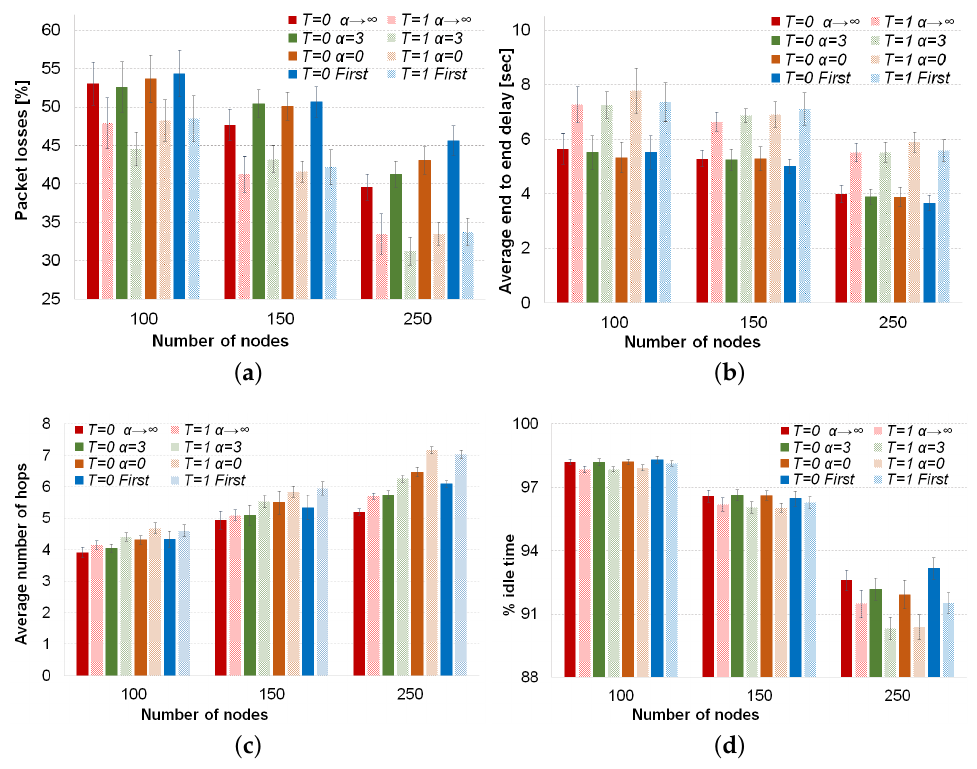
Figure 4. Performance evaluation of the forwarding techniques ( FT ) included in our proposed GHR. T = 1 means that our Tabu routing is used. The four FT are: best node selection ( α → ∞ ), simulated annealing ( α = 3), random forwarding ( α = 0) and first legal node ( First ). ( a ) Percentage of packet losses; ( b ) average end-to-end packet delay; ( c ) average number of hops; ( d ) percentage of idle